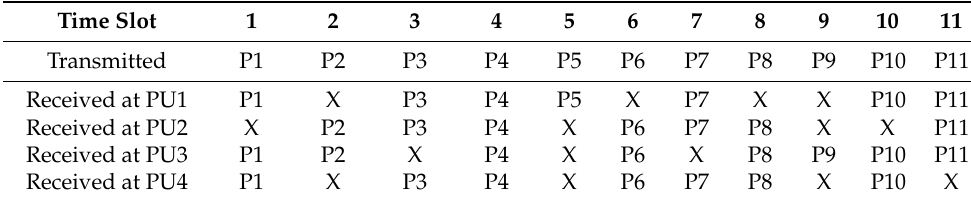
Table 1. Received packets after the first transmission.